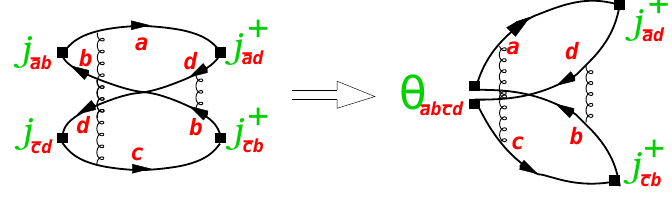
Figure 8. Flavour- rearranging correlation function [7]: lowest-order tetraquark-phile contribution only once contracted to one tetraquark-interpolating operator, leaving two quark-bilinear currents